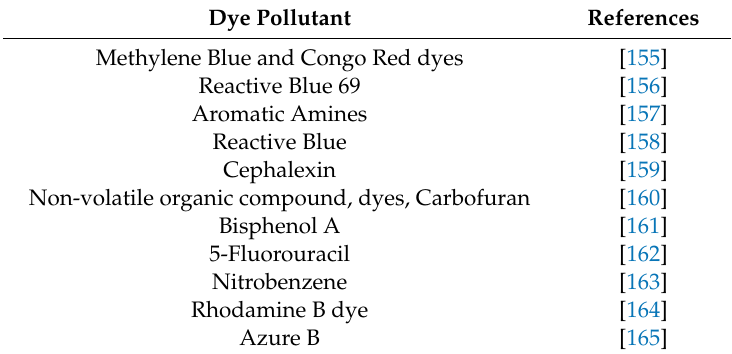
Table 3. Degradation of wastewater pollutants by sono-Fenton and sono-photo-Fenton processes. Dye